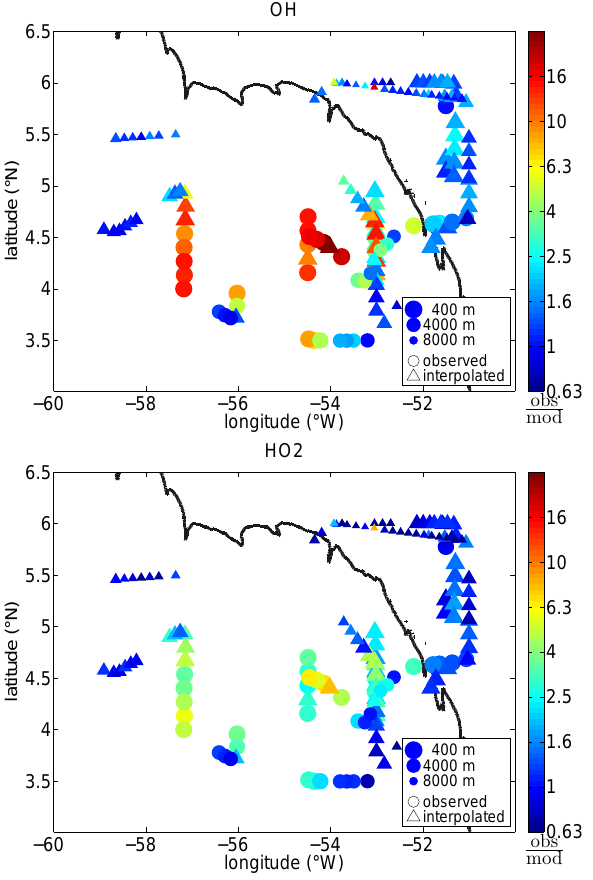
Fig. 8. Ratio of observed to simulated OH and HO 2 . The black line represents the coastline. Fig. 9. Error estimates for the simulations due to measurement uncertainties. The solid line represents the perfect match of simulation and observations. The dashed lines correspond to ratios of 1:2 and 2:1. Red points illustrate deviations by more than a factor of 2 ± 1